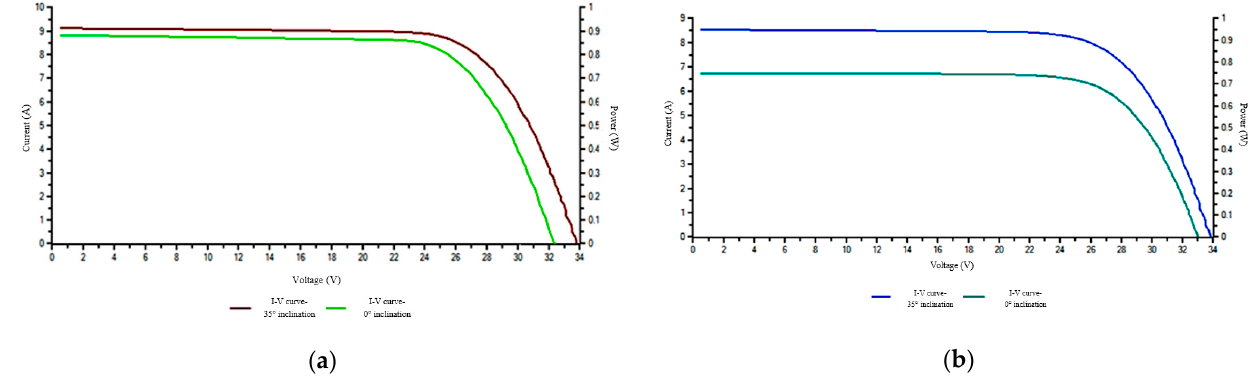
Figure 12. Voltage-current diagram of tilted and horizontal panels. ( a ) summer, ( b ) winter.